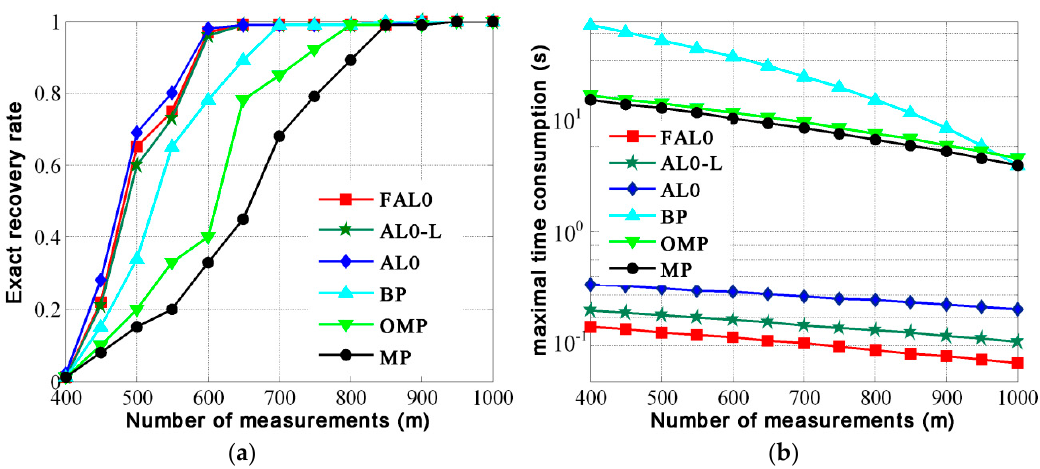
Figure 1. Performance of the six algorithms with different measurements. ( a ) Exact recovery rate; ( b ) maximal time consumption.